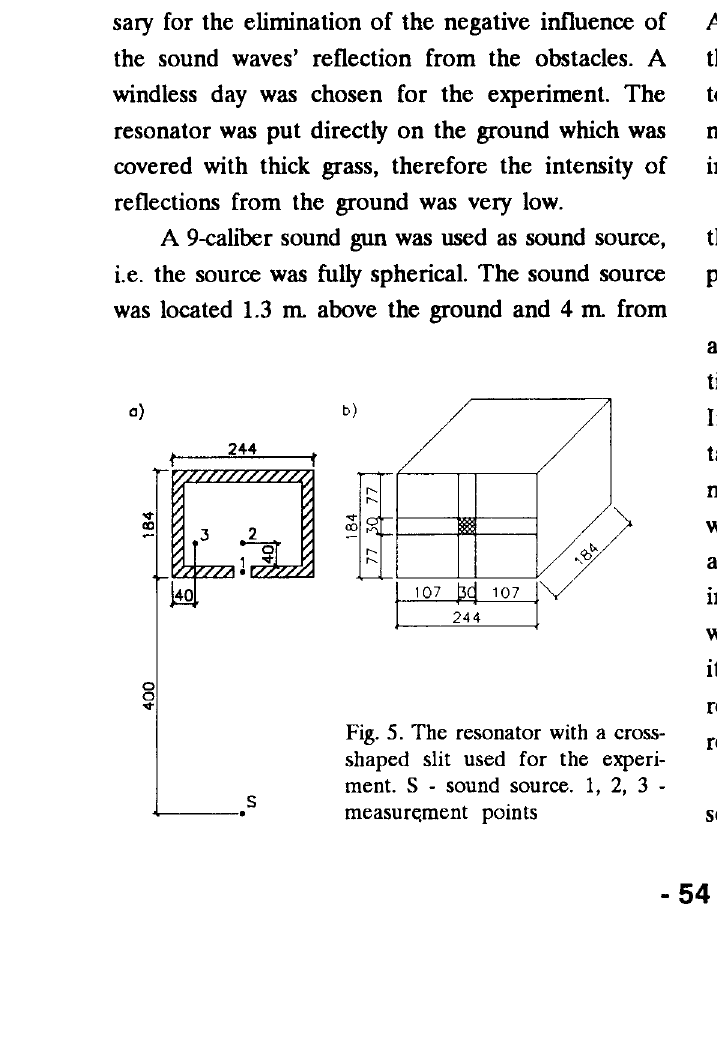
Fig. 5. The resonator with a cross shaped slit used for the experi ment. S - sound source. 1, 2, 3 - measun;ment